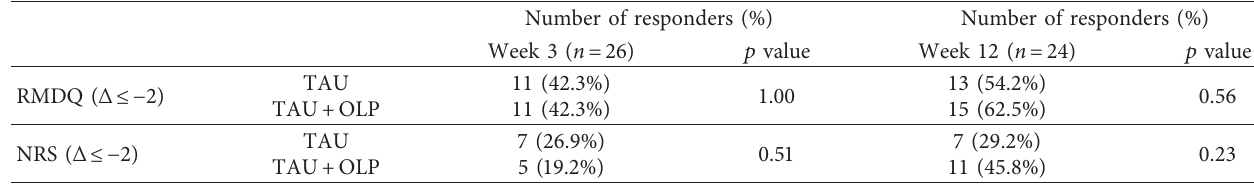
Table 3: Responders at week 3 and week 12.